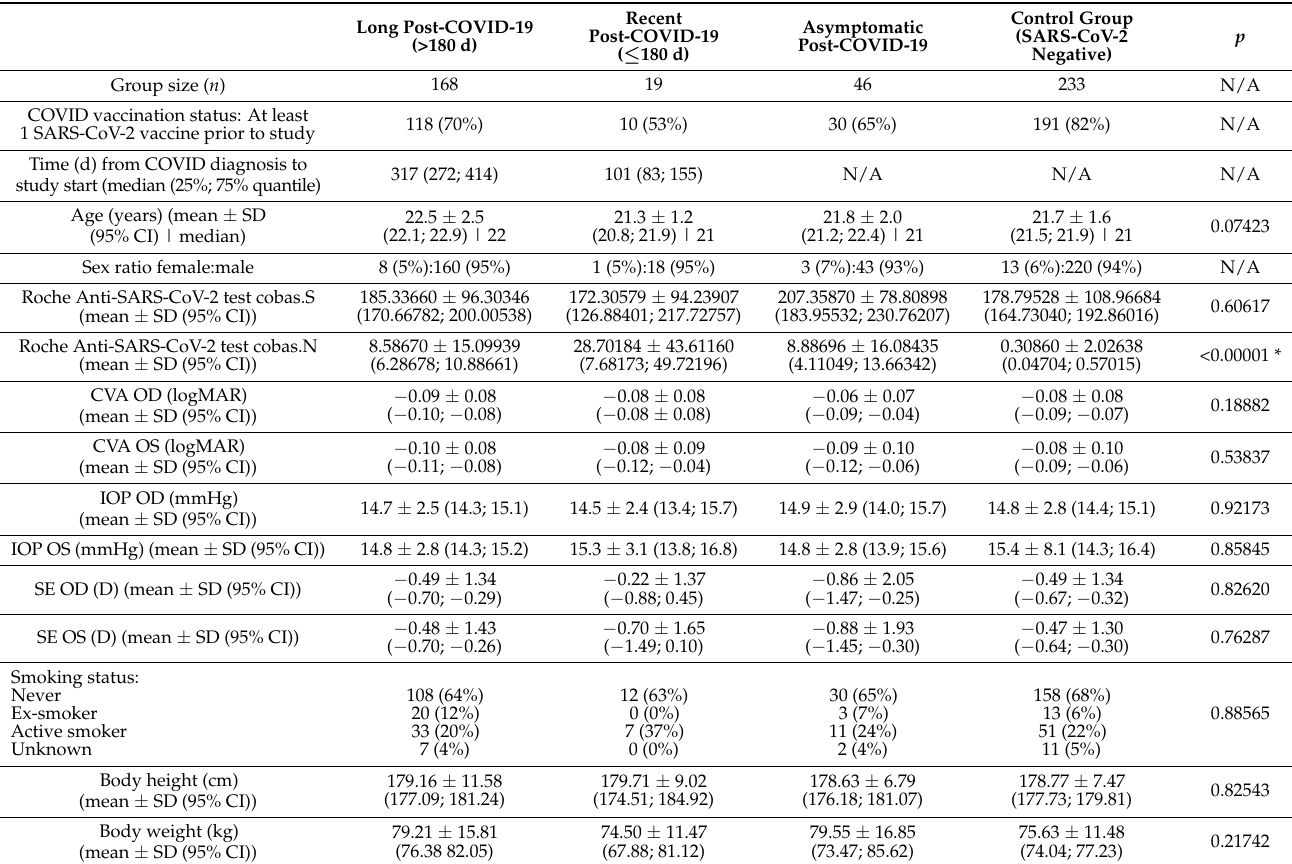
Table 1. Demographic data.